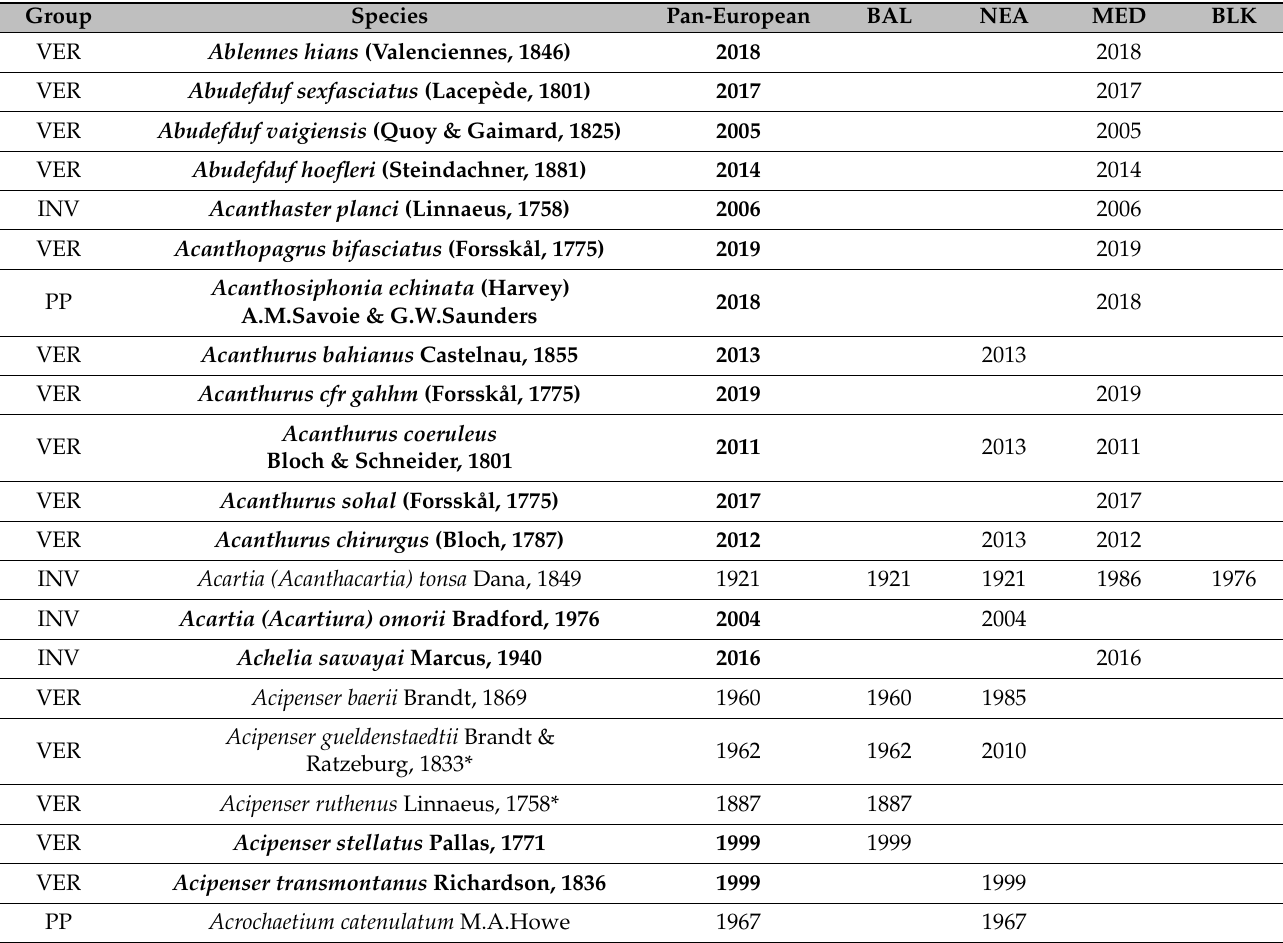
Table 2. List of NIS and their first year of detection at pan-European and regional levels. Group: VER = vertebrate, INV = invertebrate, PP = primary producer, INV/par = parasite, PP/micro = microalgae. BAL = Baltic Sea, NEA = North-East Atlantic Sea, MED = Mediterranean Sea, BLK = Black Sea. In bold, species detected since 1970. Asterisk denotes freshwater species detected in marine/ estuarine